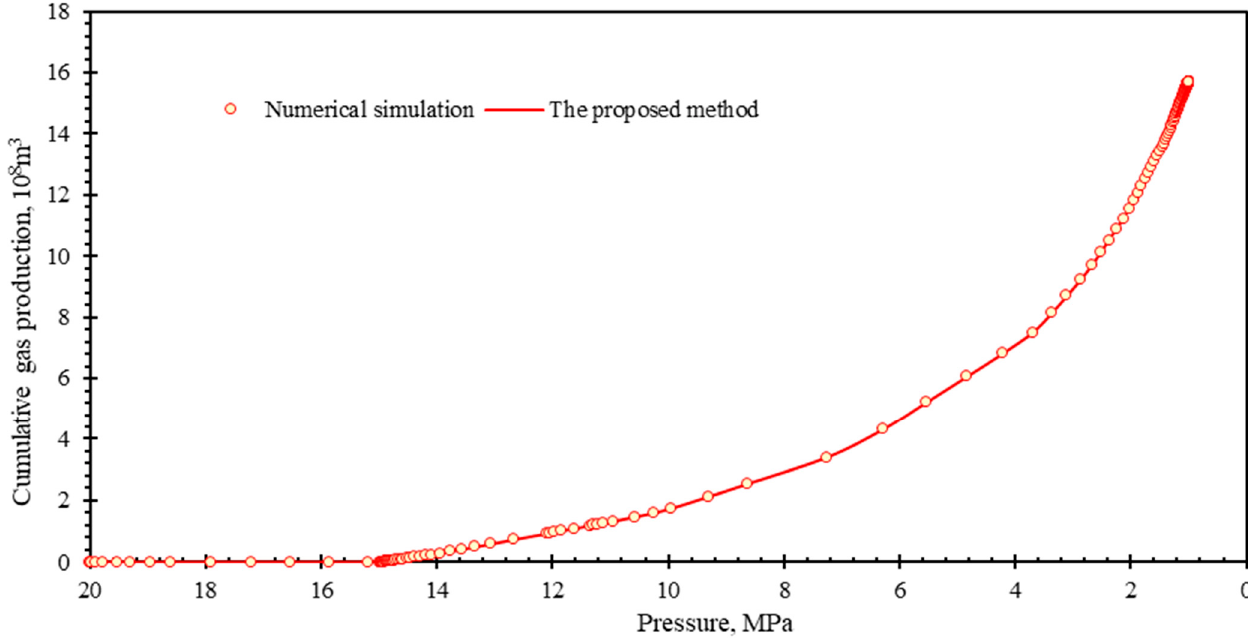
Figure 9. Comparison results of cumulative gas production with numerical simulation.